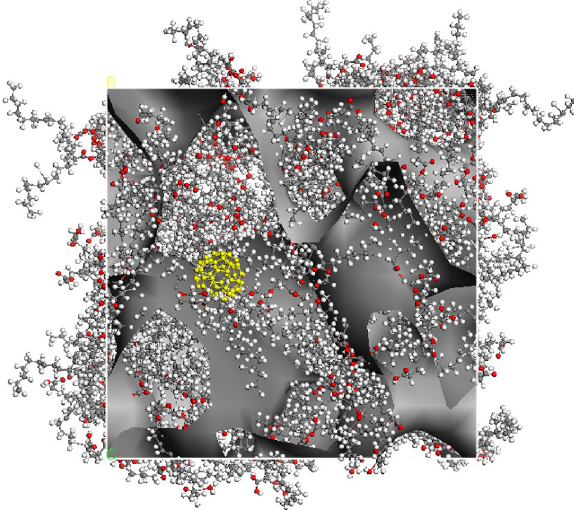
Figure 11. A density field of oleic residues in a system under